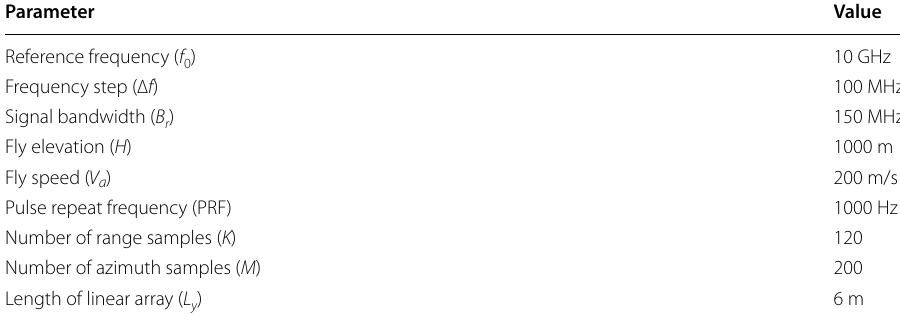
Table 3 System parameters used in the